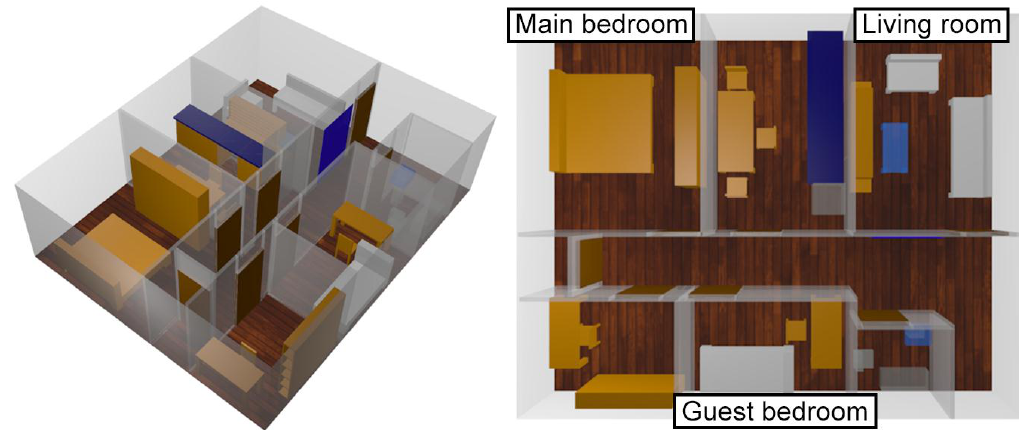
Figure 1. 3D view of the simulated measured scenario.